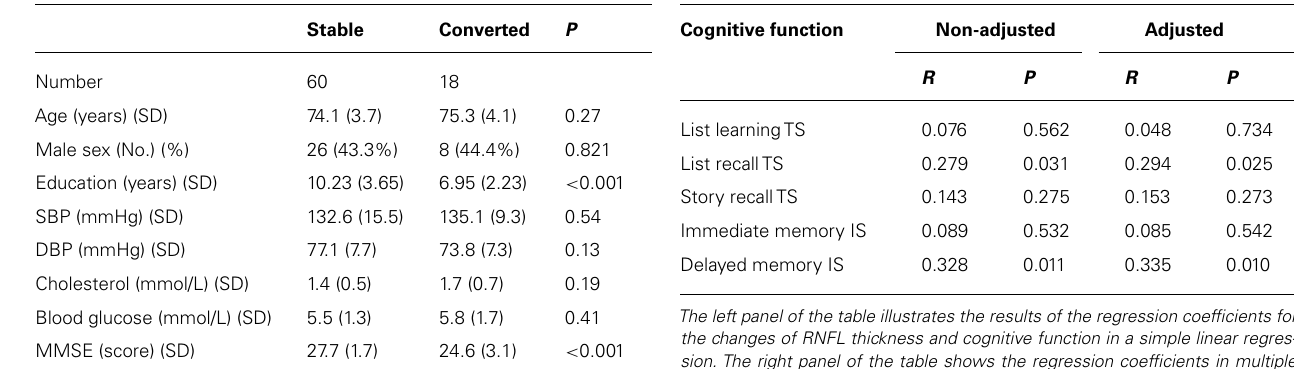
Table 2 |Association between reduction of RNFL thickness in the superior quadrant and cognitive deterioration in stable participants. Cognitive function